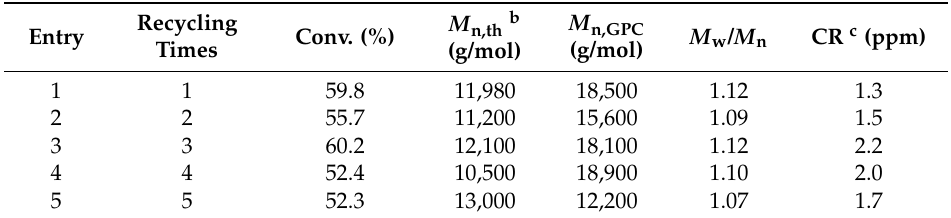
Table 4. Polymerization results of PIL recycling via TPSC-based ICAR ATRP a . Entry